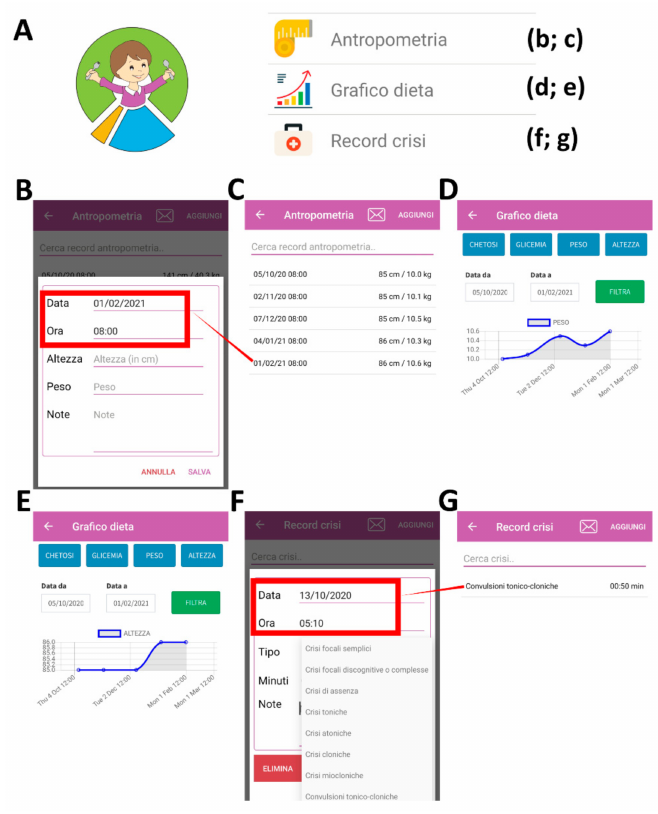
Figure 3. Using the app to record the anthropometric data and seizure values. The logo and the third part of the drop-down menu are reported in ( A ). An example of recording of the anthropometric data is reported in ( B – E ). An example of recording of the seizure values is reported in ( F , G